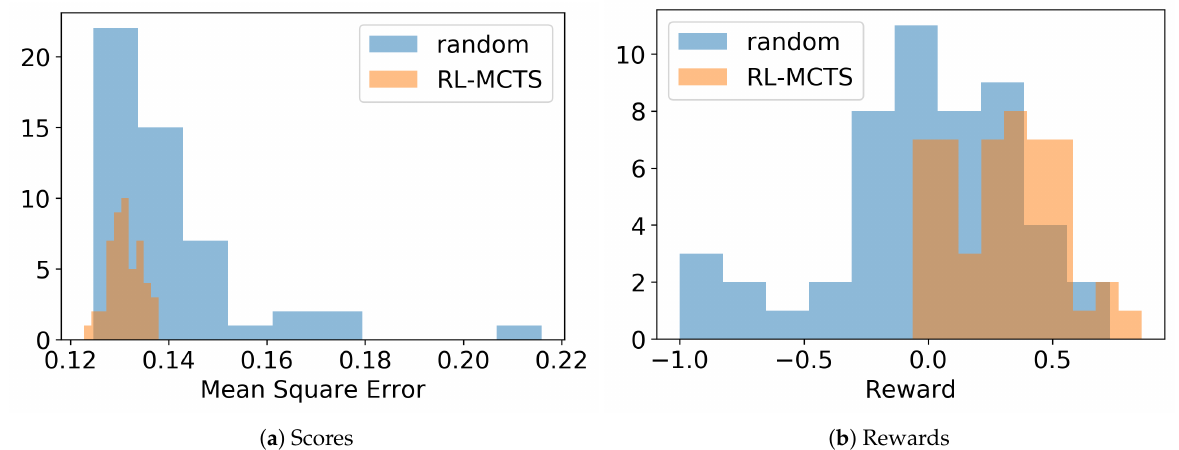
Figure 7. Comparison of the scores ( a ) and reward ( b ) between random and the proposed sam- pling